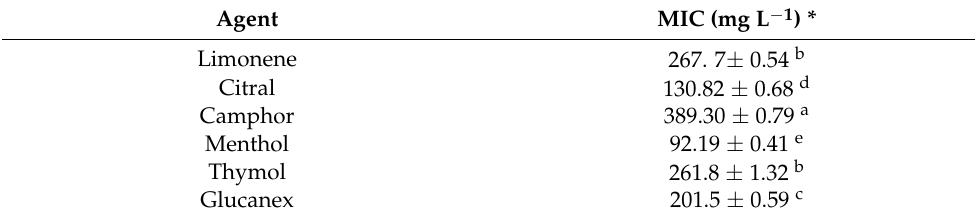
Table 1. MIC for volatiles and Glucanex on Arcopilus aereus MaC7A.